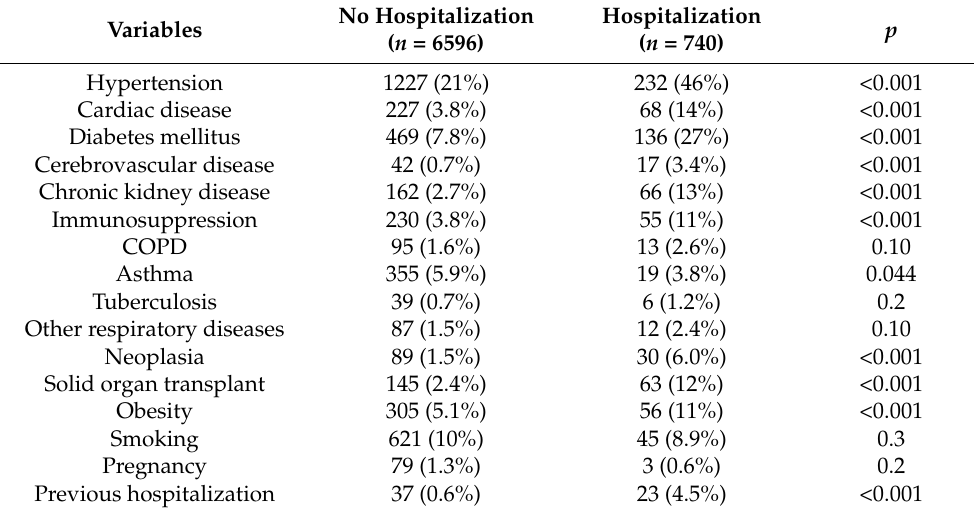
Table 2. Comparison of comorbidities between patients who required hospitalization and those who did not require hospitalization from March to August 2020 at S ã o Paulo Hospital, Brazil.